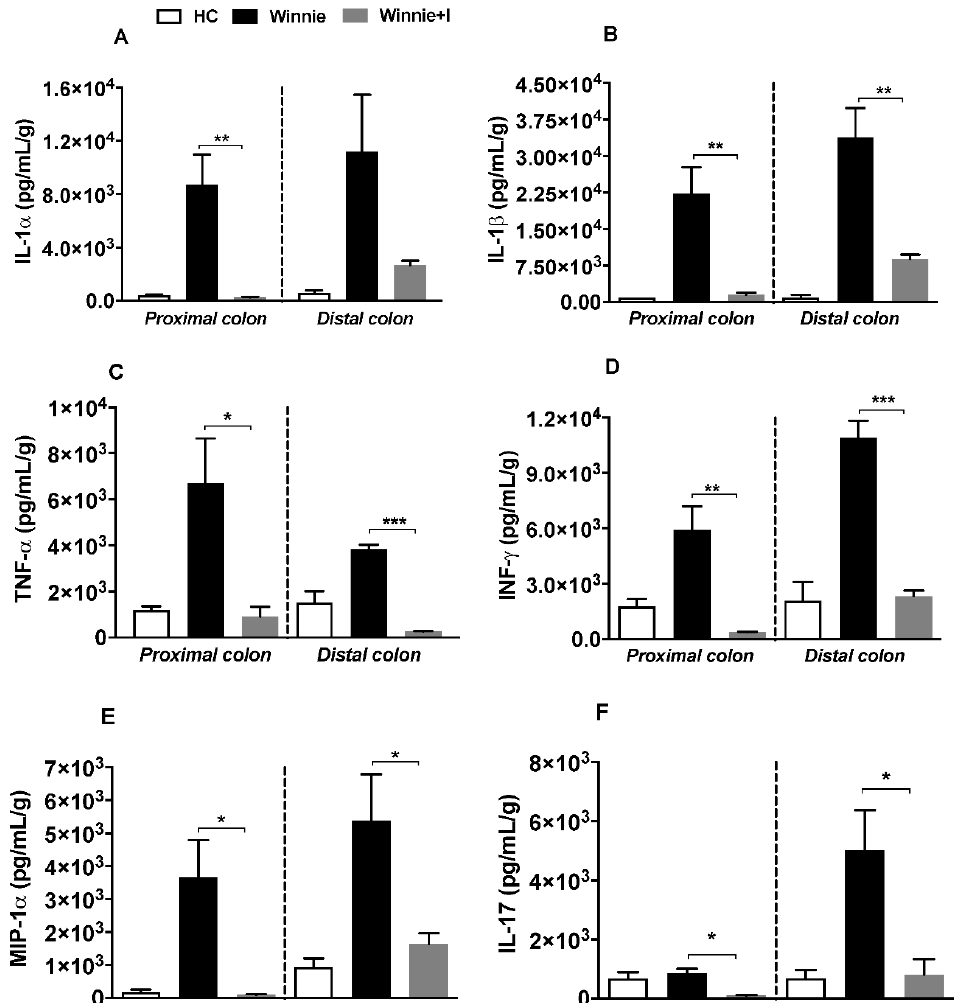
Figure 6. Effect of idebenone on the levels of pro-inflammatory cytokines and chemokines in colonic tissue explants of Winnie mice. Tissue levels of ( A ) IL-1 α , ( B ) IL-1 β , ( C ) TNF- α , ( D ) INF- γ , ( E ) MIP-1 α and ( F ) IL-17 in proximal colon and distal colon were quantified by Bio-Plex assay. Data expressed as mean ± SEM ( n = 3 / group) and statistical significance evaluated by One-way ANOVA followed by Tukey’s post-test where * p < 0.05 , ** p < 0.01 and *** p < 0.001.